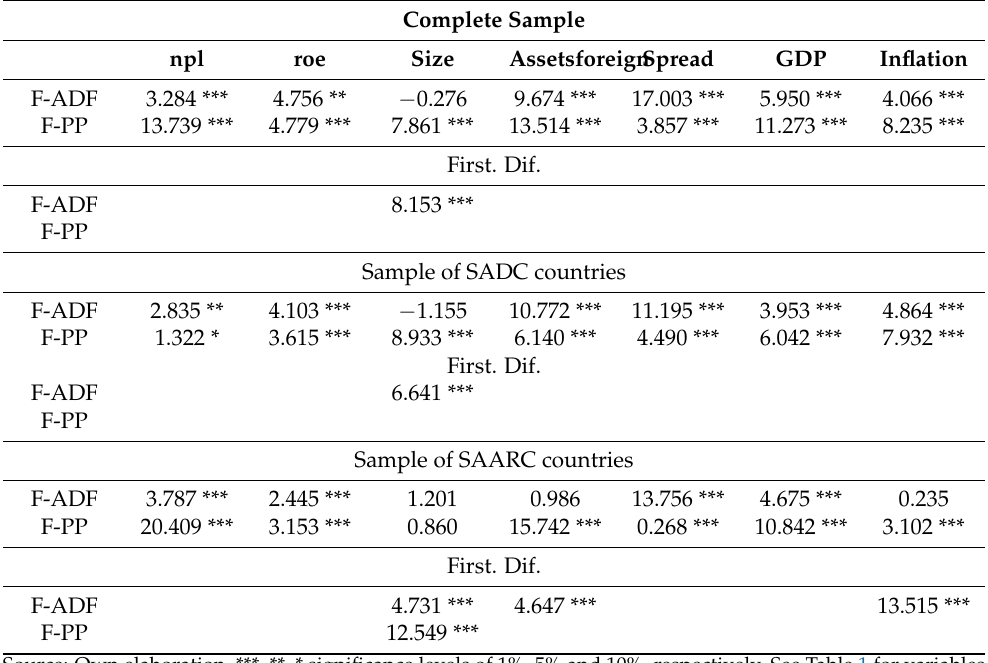
Table 5. Panel unit root test for the control variables of the